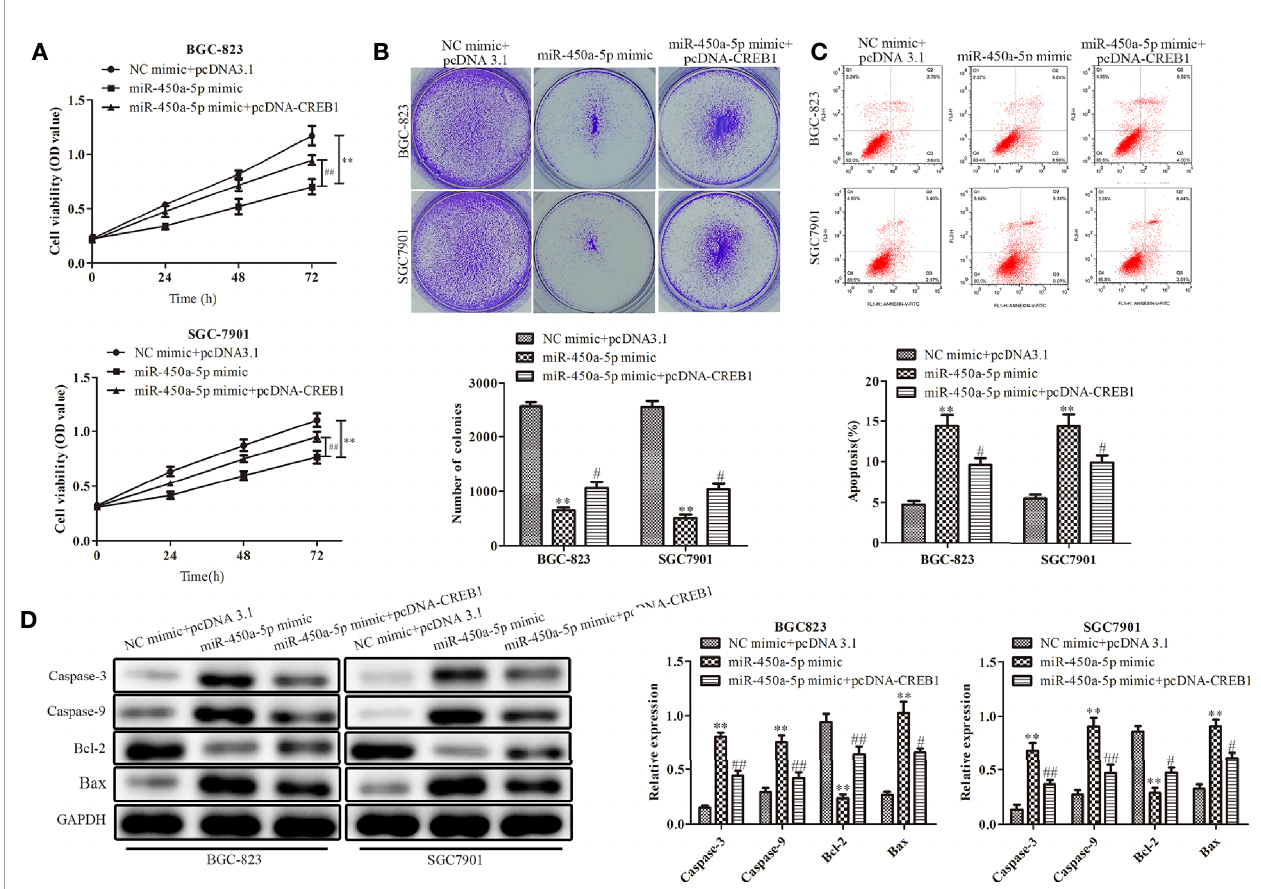
FIGURE 6 | CREB1 overexpression partially restores the effects of miR-450a-5p on gastric cancer. (A, B) CCK-8 assay and colony formation assay on the cell proliferation of BGC-823 and SGC-7901 cells. (C) Flow cytometry on the cell apoptosis of BGC-823 and SGC-7901 cells. (D) Western blot analysis evaluated the expression of apoptosis-associated proteins in BGC-823 and SGC-7901 cells. ** P <0.01 vs. NC + pcDNA3.1 group. # P <0.05, ## P <0.05 vs. miR-450a-5p mimic